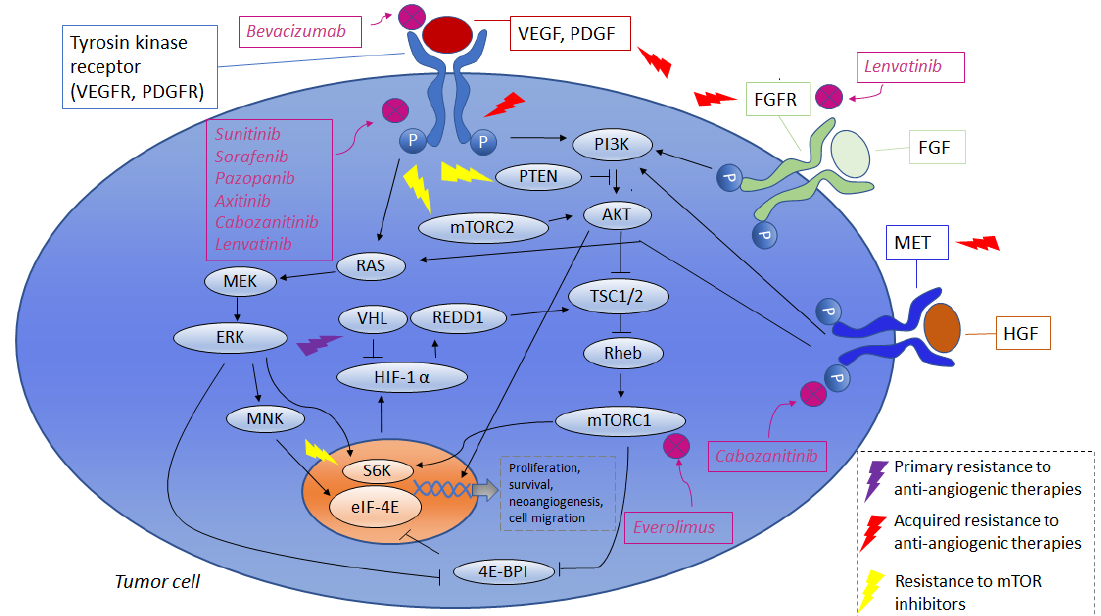
Figure 1. Resistance to anti-angiogenic therapies and mTOR inhibitors: VEGF or PDGF bind to a tyrosine kinase receptor and activate the PI3K and RAS pathways. PI3K activates the serine / threonine kinases AKT and mTOR. RAS activates MEK, which, in turn, activates ERK. ERK activates MNK, which, in turn, phosphorylates and activates eIF-4E. ERK and mTORC1 activate p70 S6K which, in turn, phosphorylates 4E-BP1, preventing it from binding to eIF-4E (which would cause the inactivation of the latter). The PI3K and RAS pathways result in the translation and accumulation of HIF-1 α , that translocates to the nucleus and dimerizes with the constitutively-expressed HIF-1 β . This complex binds to hypoxia response elements in the promoters of target genes, resulting in the transcription of genes that regulate cell growth, angiogenesis, cell survival and cell proliferation. Other pathways that may be implicated in resistance to anti-angiogenic therapies are those which are regulated by MET and FGFR. MET is activated by the binding of HGF, while FGFR is activated by FGF; this results in the activation of the RAS – MAPK and PI3K – AKT pathways, leading to the